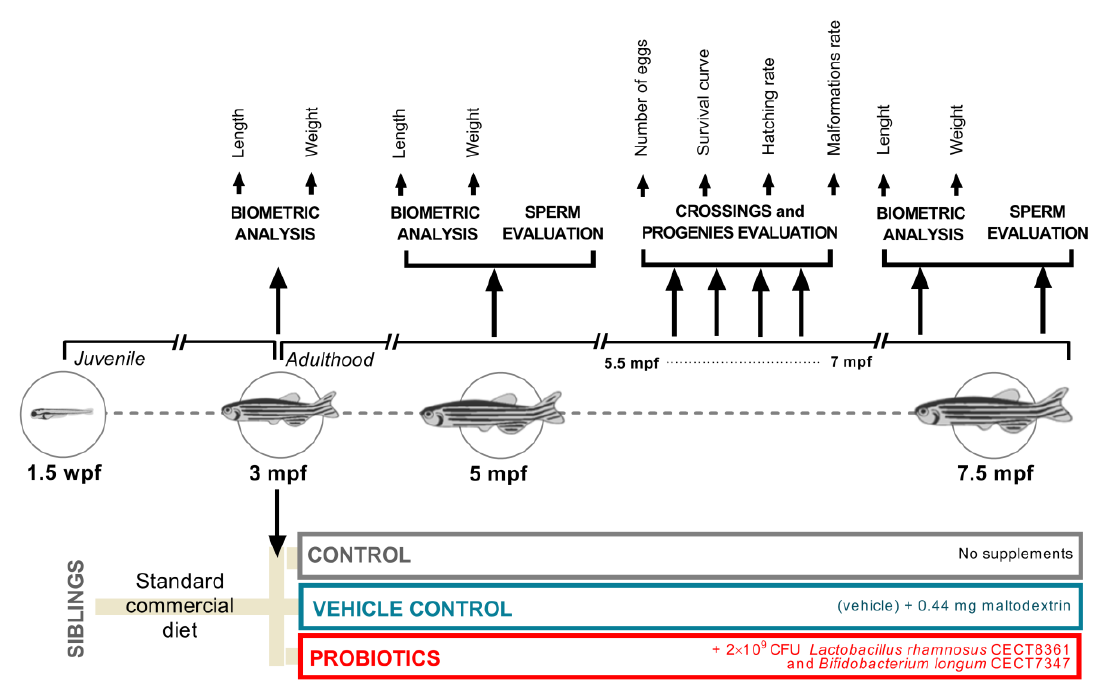
Figure 1. Design summary. wpf: weeks postfertilization; mpf: months postfertilization.